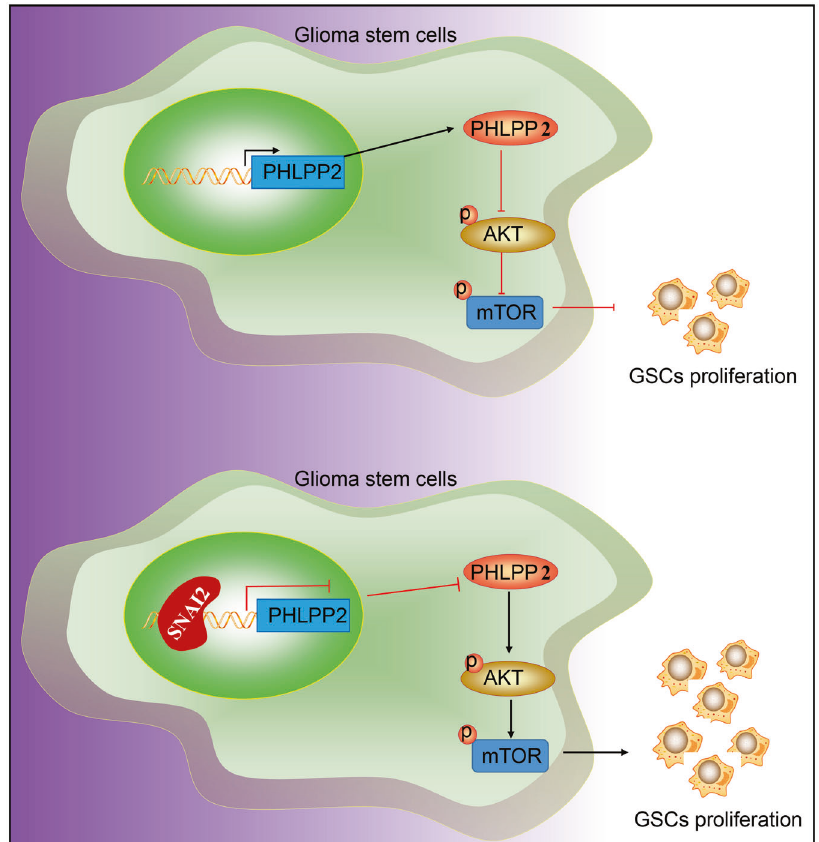
Fig. 7 Molecular mechanism regarding the role of SNAI2 in GSCs via the Akt pathway by regulating PHLPP2 in GSC proliferation. SNAI2 downregulates PHLPP2 to activate the Akt pathway, thereby promoting the proliferation of